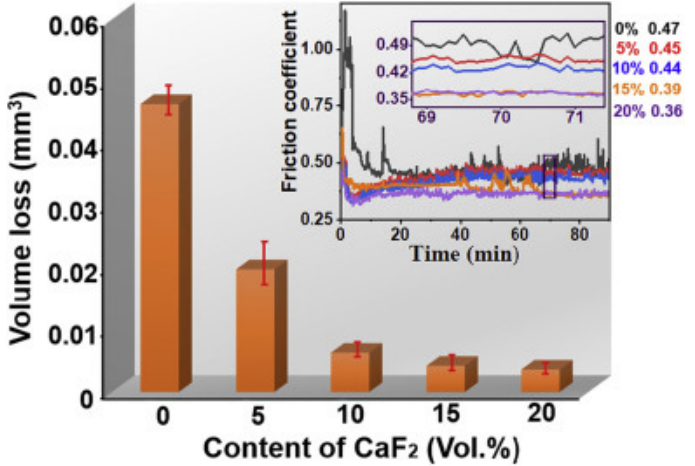
Figure 12. The variation in CoF and wear volume loss with different wt. % of CaF 2 during dry sliding conditions. Reproduced with permission from [97]. Copyright Elsevier,